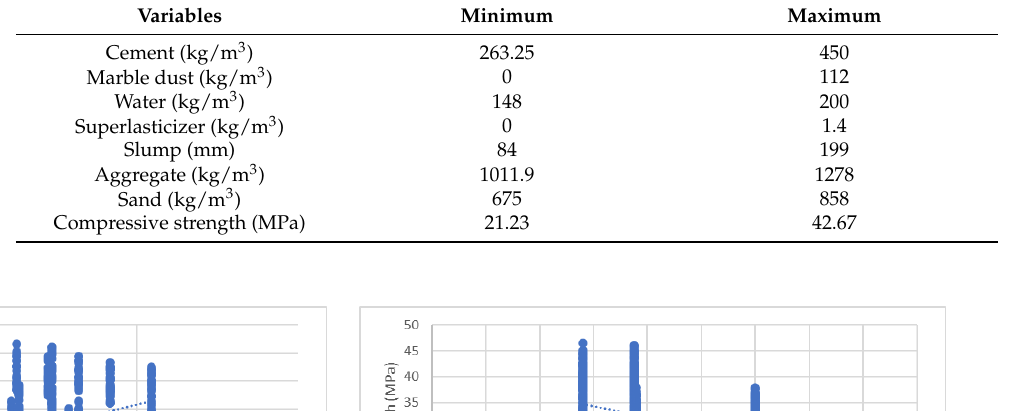
Table 3. Range of parameters used for Modelling.